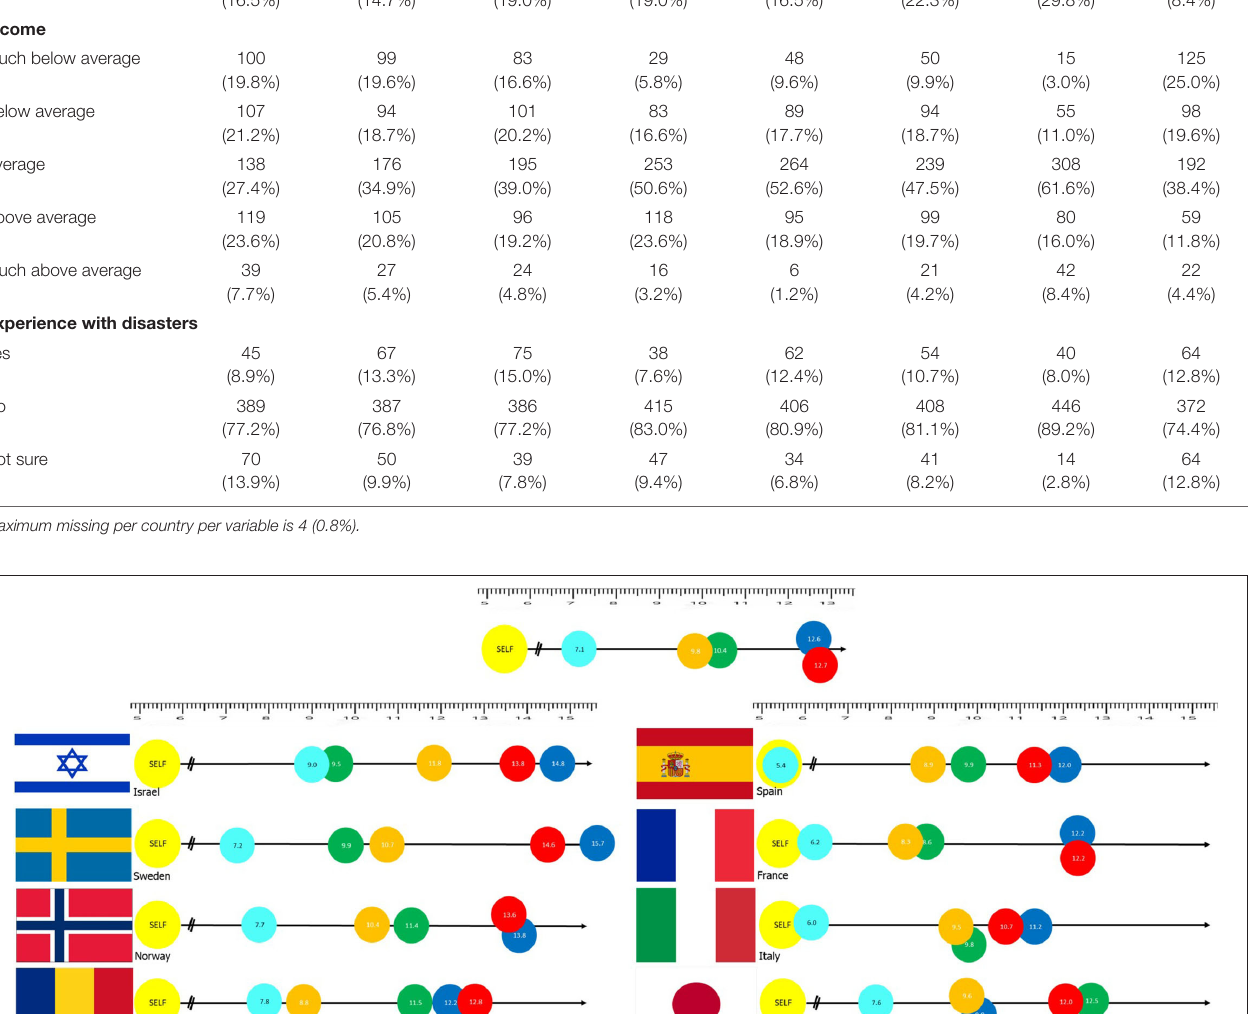
SE = 0.22, p < 0.001). Analysis of each hazard separately reveals additional findings (see Figure 2 ). While all age groups perceived the pandemic threat as the highest risk (placed the disc similarly close to oneself), differences between nationalities were identified concerning the other types of